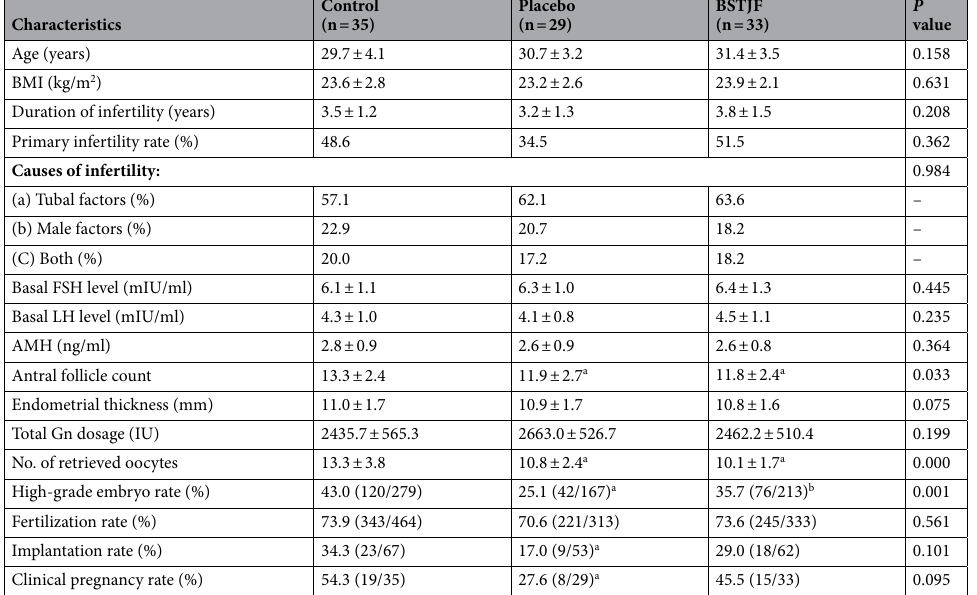
Table 1. Clinical characteristics and pregnancy outcome indexes of infertile patients. One-way analysis of variance, Student’s t test and Pearson’s chi-square test were used, with the data in mean ± standard deviation or n (%). Control: patients with first-cycle COS; Placebo: repeated COS for 3–5 cycles and treated with placebo; BSTJF: repeated COS for 3–5 cycles and treated with BSTJF. n number of patients, BMI body mass index, AMH antimullerian hormone, hCG human chorionic gonadotrophin, Gn gonadotropic hormone, BSTJF Bushen- Tiaojing-Fang, COS controlled ovarian stimulation. a P < 0.05 versus the control group. b P < 0.05 versus the placebo